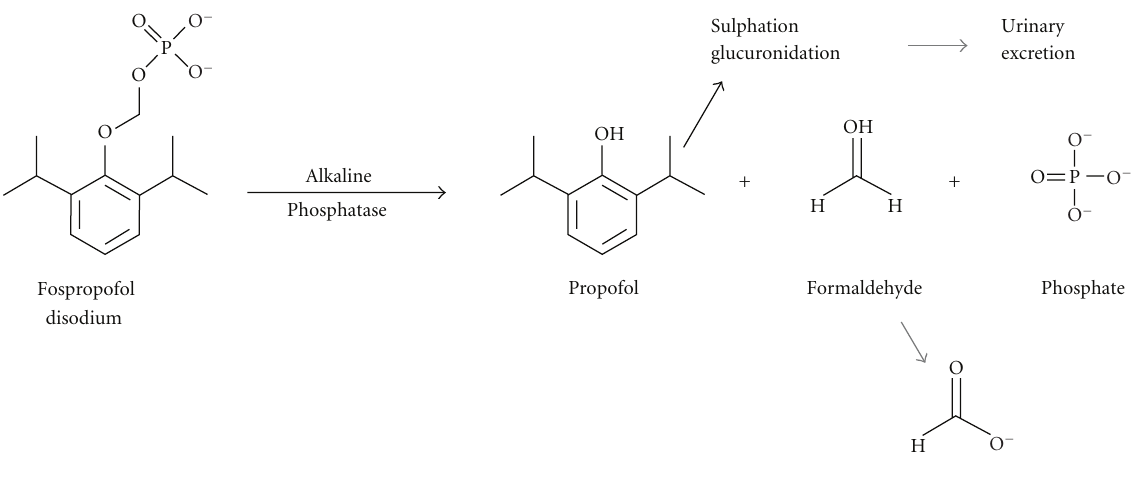
Figure 1: Formaldehyde converting to aldehyde dehydrogenase and then to formic acid